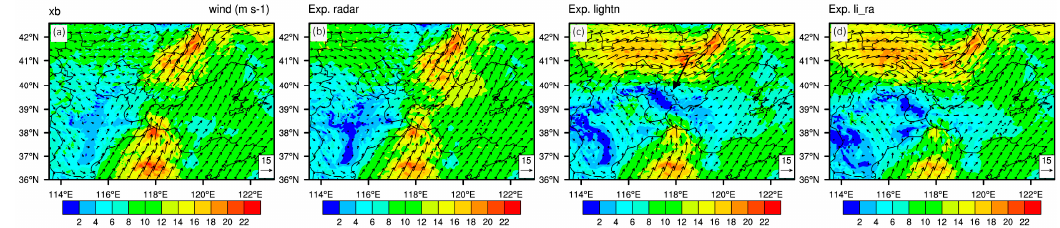
Figure 4. Background (xb) ( a ); and analyzed fields for ( b ) Exp. Radar;( c ) Exp. Lightn; and ( d ) Exp. li_ra for wind (m·s − 1 ) (at level = 8, about 1.5 km) at 0300 UTC.